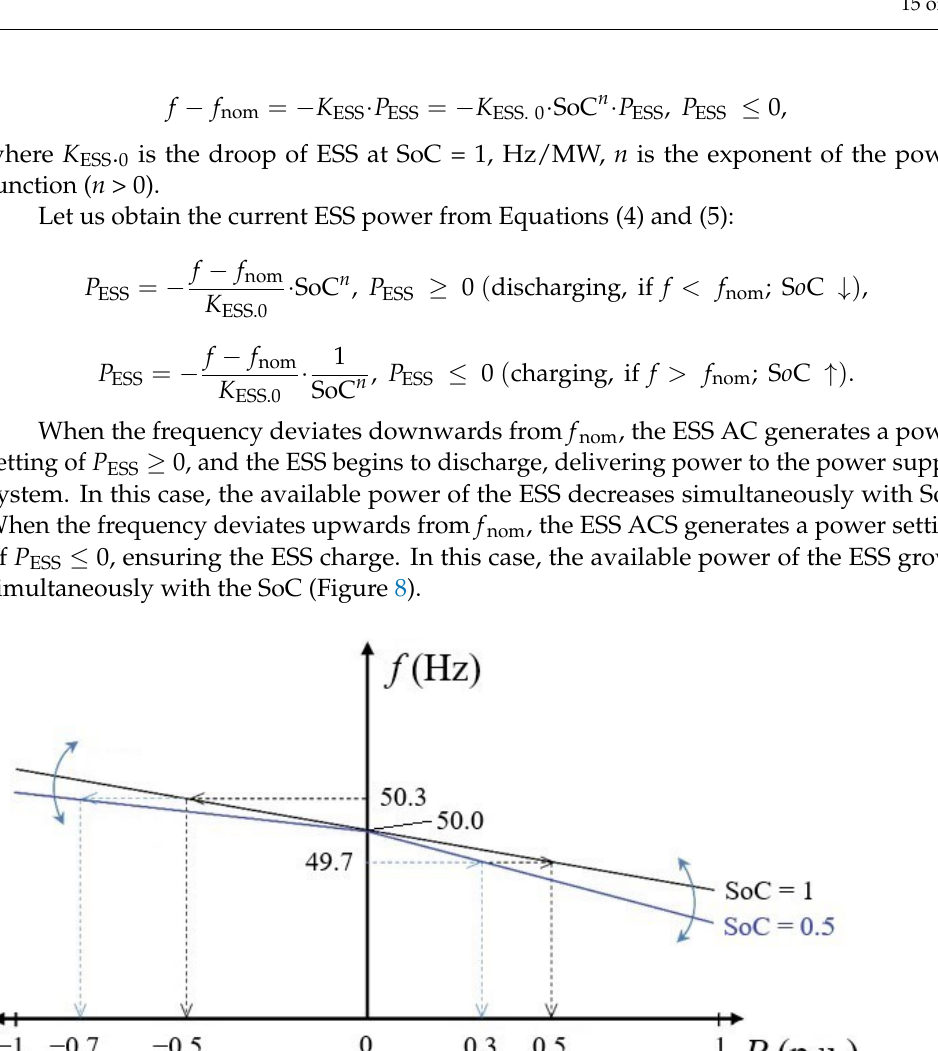
( b ) Figure 9. Graphs of the sensitivity of P ESS to changes in n depending on SoC values: ( a )—ESS charg- ing mode; ( b )—ESS discharging mode. The analysis of Figure 9 shows that as the value of n increases, the ESS response to changes in SoC increases significantly, so it is advisable to limit the range of SoC change (set the setpoints), within which the method developed by the authors will be effective. The second degree of freedom in Equation (3) is the frequency ( f ); therefore, it is pos- sible to offset the steady-state characteristic along the frequency axis by some value Δ f as a function of the SoC value. In this case, Equations (6) and (7) for the ESS power take the form: 𝑃 (cid:2889)(cid:2903)(cid:2903) = − (cid:4666)(cid:3033)(cid:2879)(cid:3033) (cid:3172)(cid:3173)(cid:3171) (cid:4667)(cid:2879)(cid:2940)(cid:3033) (cid:3012) (cid:3137)(cid:3151)(cid:3151).(cid:3116) , P ESS ≥ 0 (discharging, if f < f nom ; S о C ↓ ), (8)